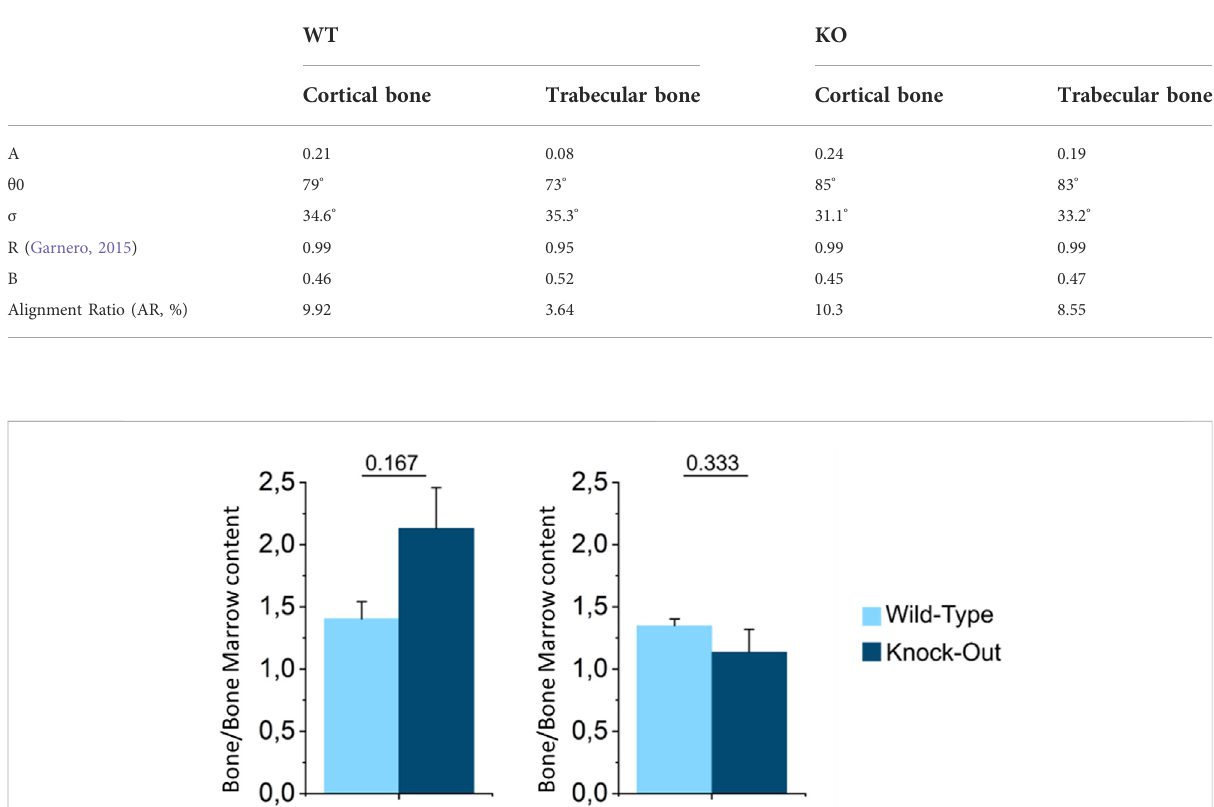
TABLE 3 Optimal parameter values that maximize the R2 of the fi t for data collected with the pump beam perpendicular-polarized to the craniocaudal axis of the spine.